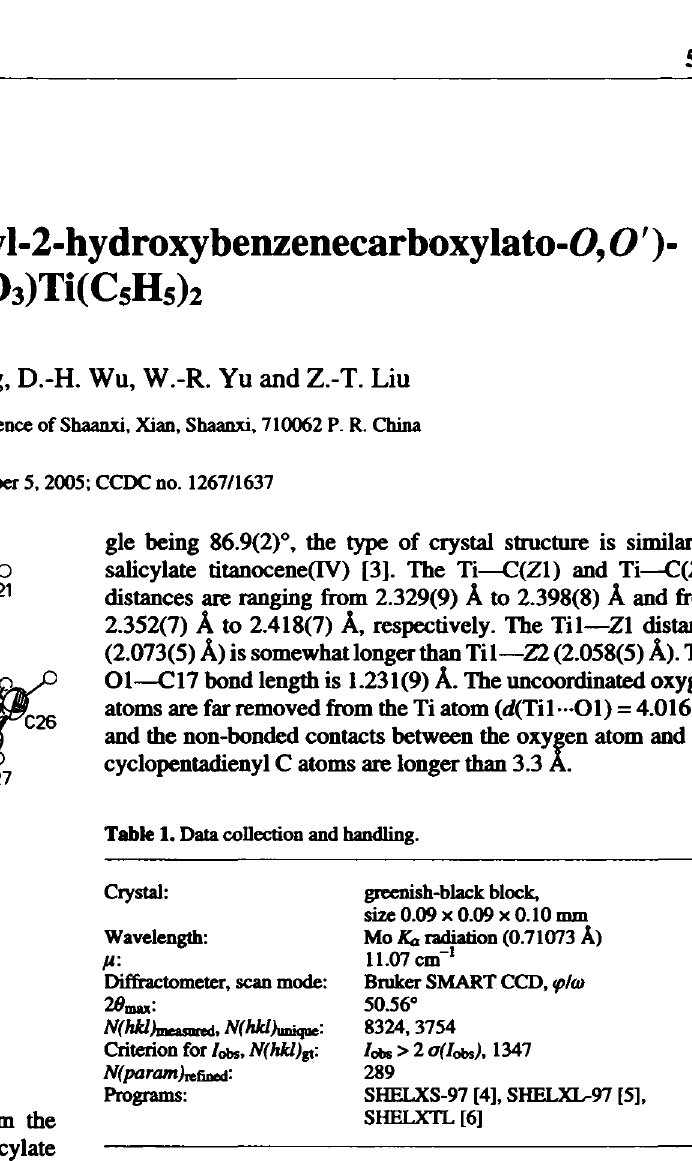
Table 2. Atomic coordinates and displacement parameters (in A 2